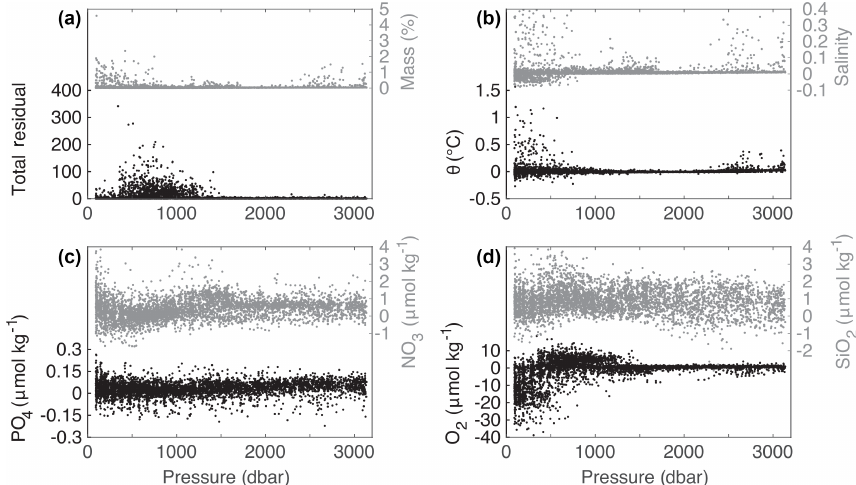
Figure 4. Residuals of the eOMP analysis for all Irminger Sea cruise data from 1991–2015 for the (a) total residual as the squared largest singular value for the set of residuals (García-Ibáñez et al., 2015) and the residual of mass conservation in %, (b) residuals of potential temperature and salinity, (c) residuals of phosphate and nitrate and (d) residuals of oxygen and silicate with respect to pressure.